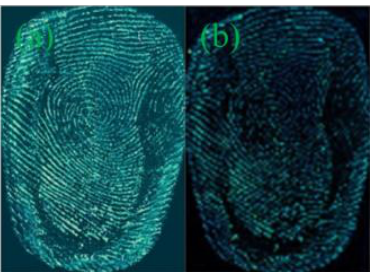
Figure 6. Fingermarks developed on the transparent tape by G-CDs of preserving time. ( a ) 1 day; ( b ) 60 days.